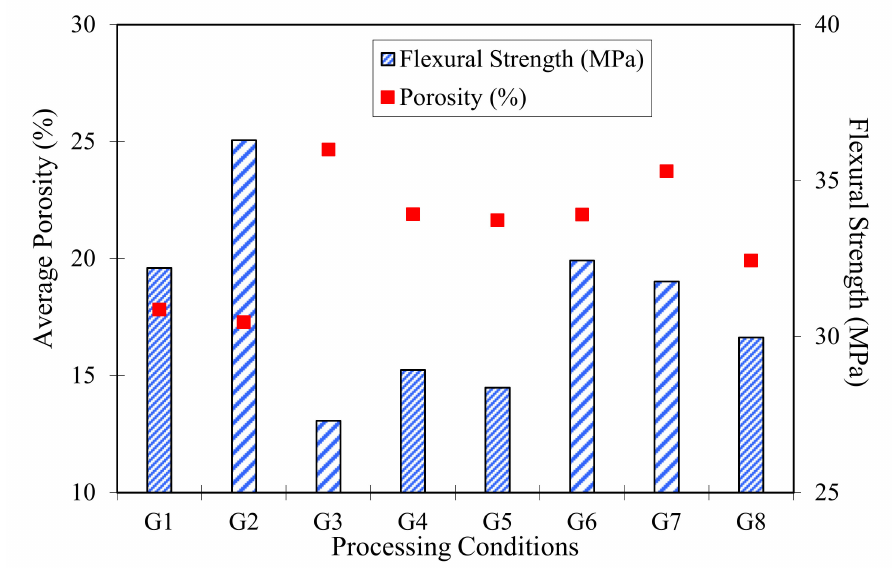
Figure 8. Flexural strength and porosity for the di ff erent group of